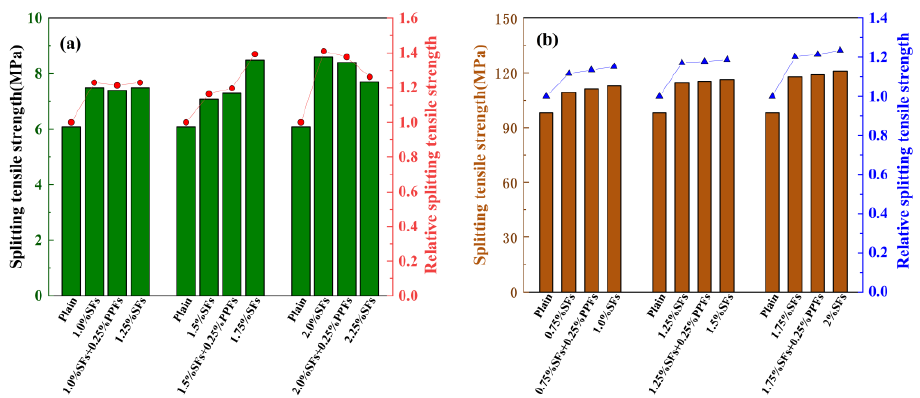
Figure 20. The effect of fiber hybrid effect on splitting tensile strength: ( a ) Data provided by [44]; ( b ) data provided by [43].